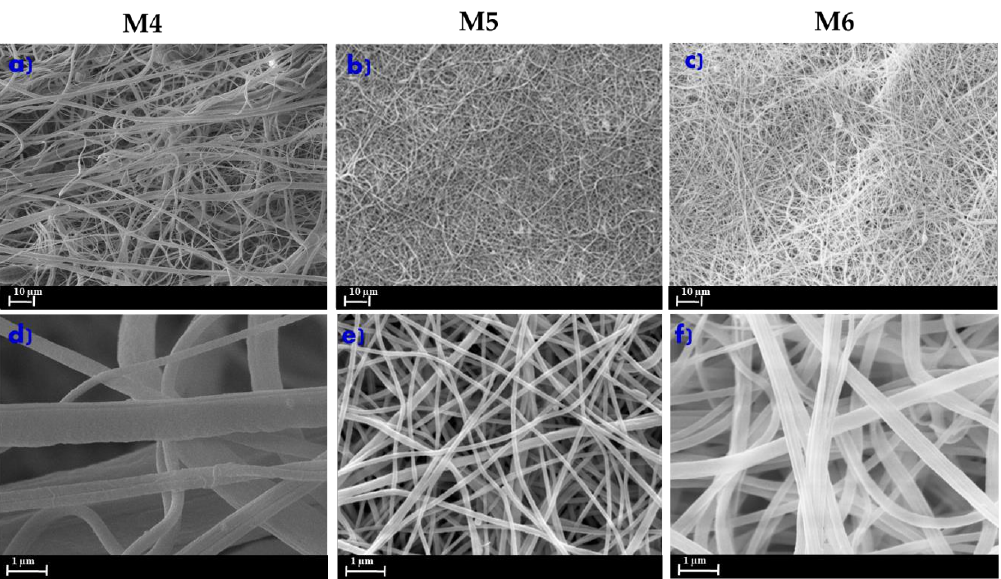
Figure 2. SEM pictures of the electrospun fiber membranes (ENMs) at different poly (vinylidene fluoride) (PVDF) polymer concentrations: a ) M4 (6 wt% PVDF), b ) M5 (8 wt% PVDF), c ) M6 (10 wt% PVDF) at 10 µm; d ) M4 (6 wt% PVDF), e ) M5 (8 wt% PVDF), f ) M6 (10 wt% PVDF) at 1 µm. Conditions